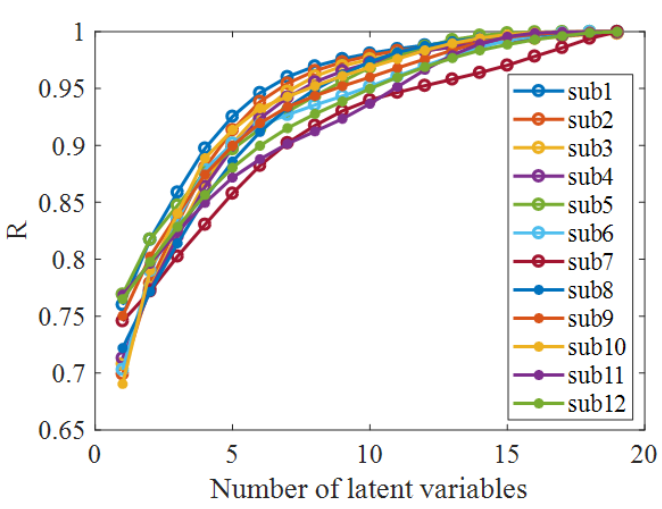
Figure 5. The reconstruction performance of VAE using different numbers of latent variables. The reconstruction performance increased with the enlargement of the latent variable number.